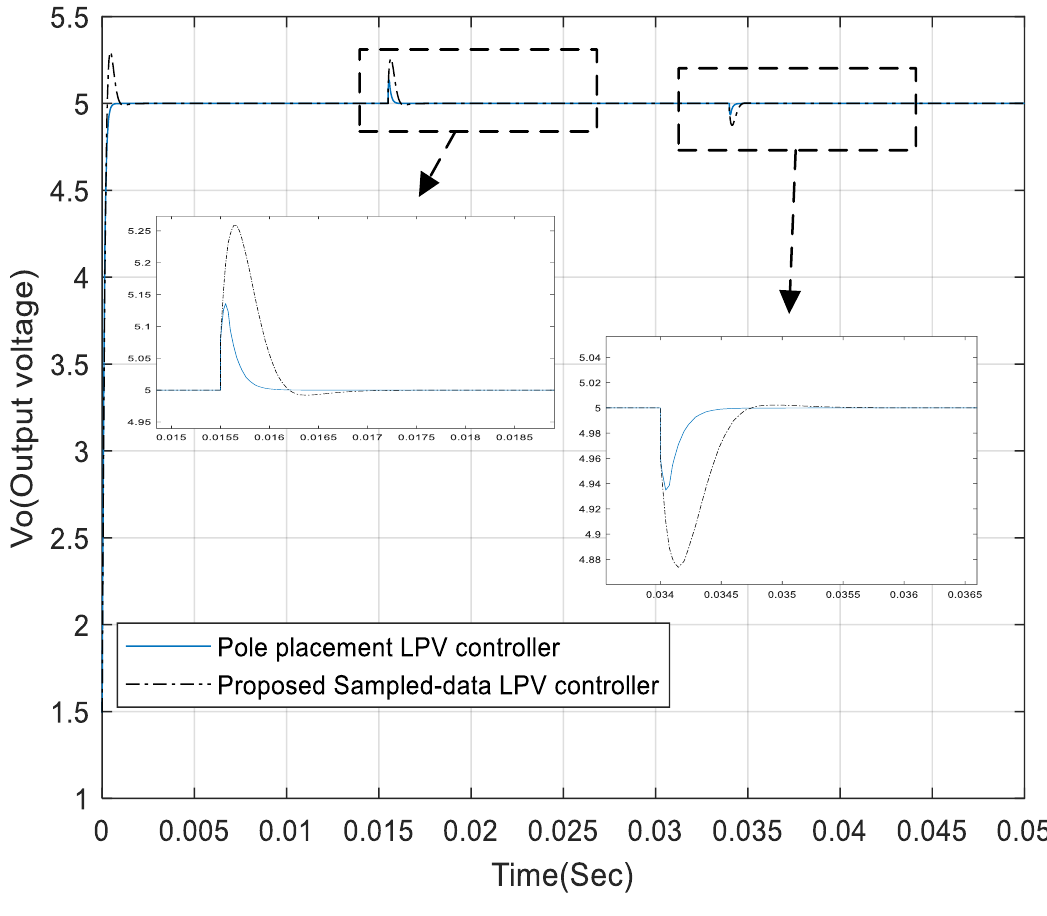
Figure 5. Comparison between output voltage response curves under the proposed controller ( T = 0.0002 s) where the load is